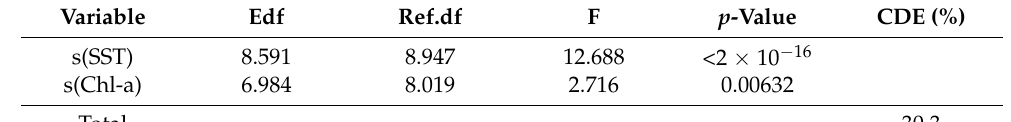
Figure 2. Probability density distribution of SST ( A ) and Chl-a ( B ) estimated from Aqua/MODIS for all skipjack catches ( n = 1248) and that of SST ( C ) and Chl-a ( D ) for commercial (mature) skipjack tuna ( n = 333) caught in the study area (IFMA 713) from 2007 to 2016. The vertical dash line indicates the average of the data. Table 2. Final GAM construction summary for the approximate significance of smooth terms.